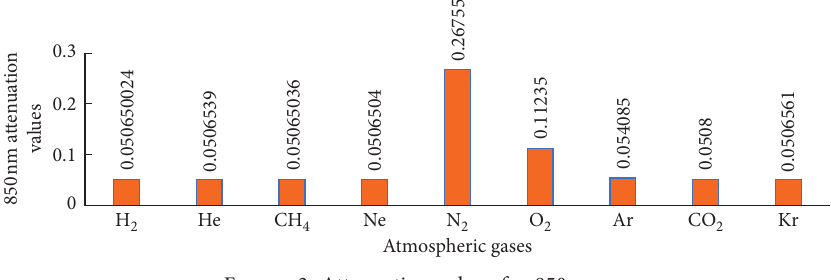
Figure 3: Attenuation values for 850nm.